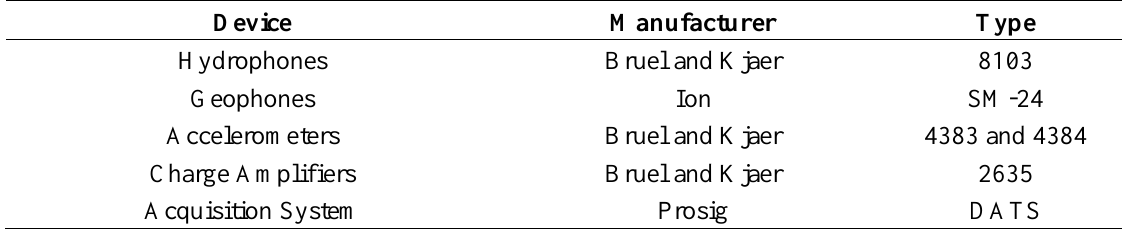
Table 2. Instrumentation used in the